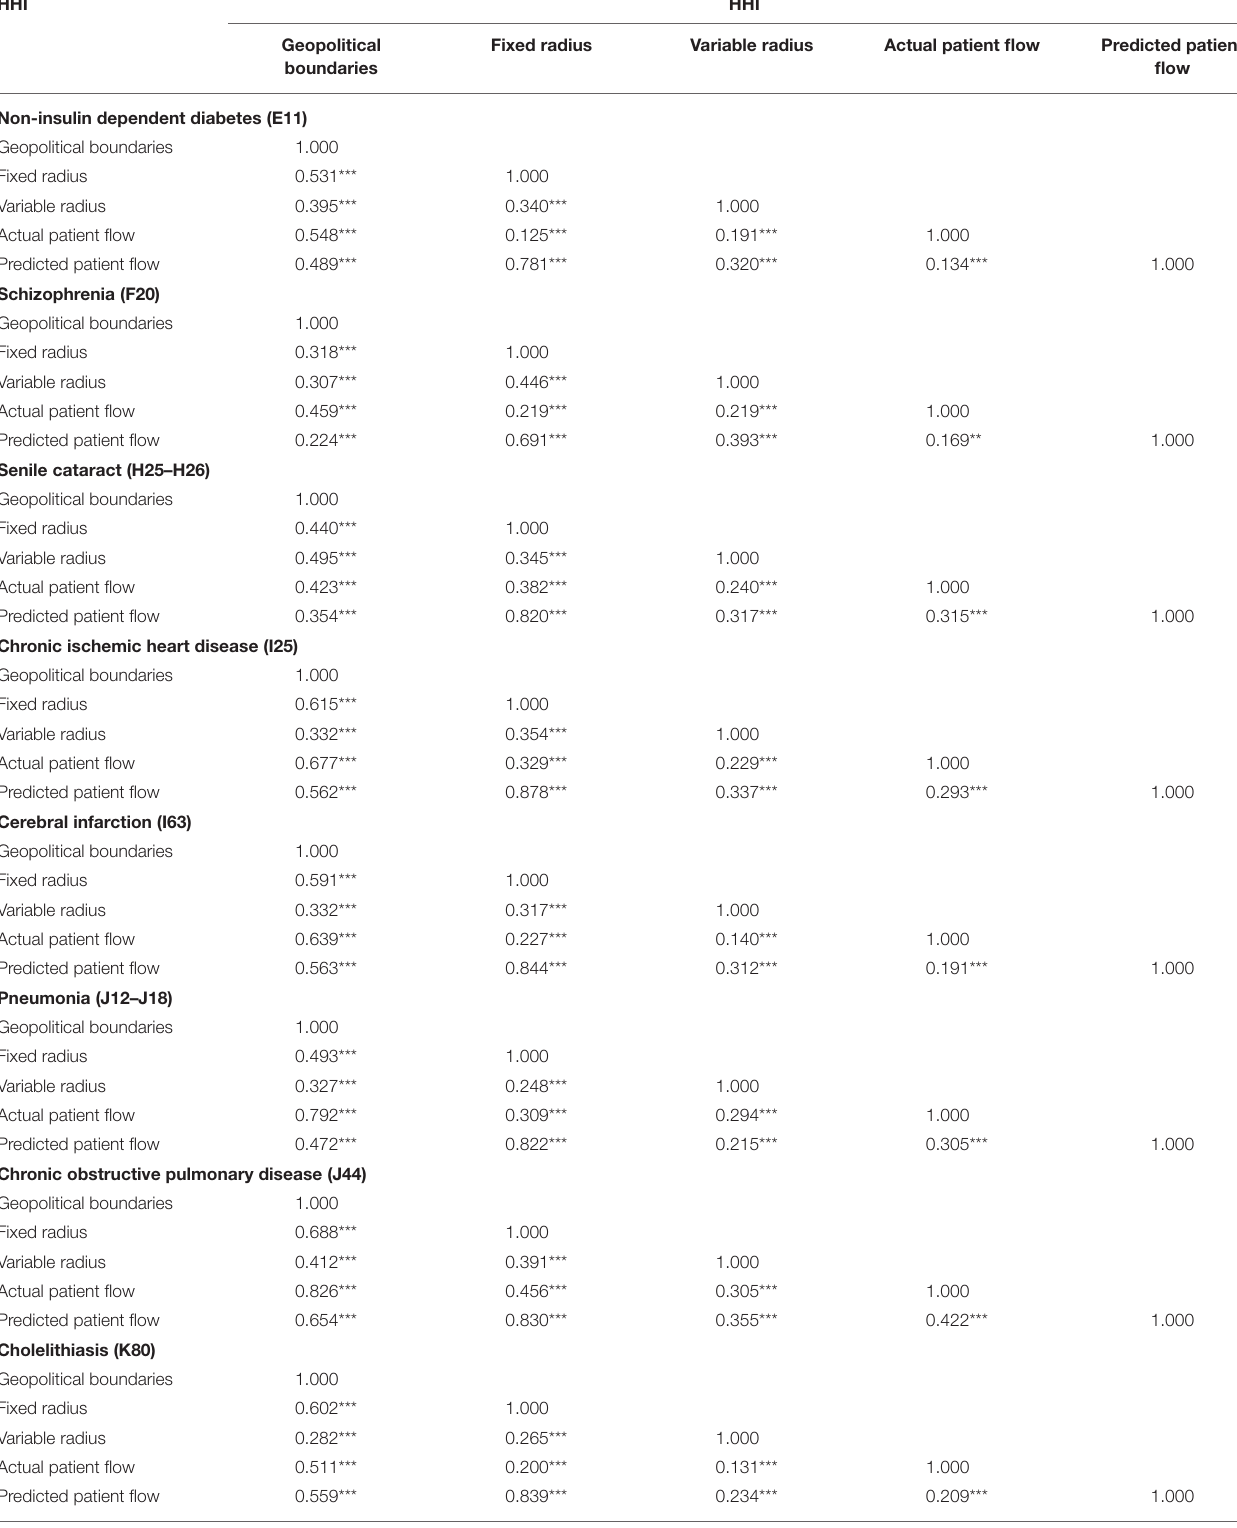
TABLE 4 | The correlation coefficient matrix of HHI of the market defined by different definition methods. HHI HHI